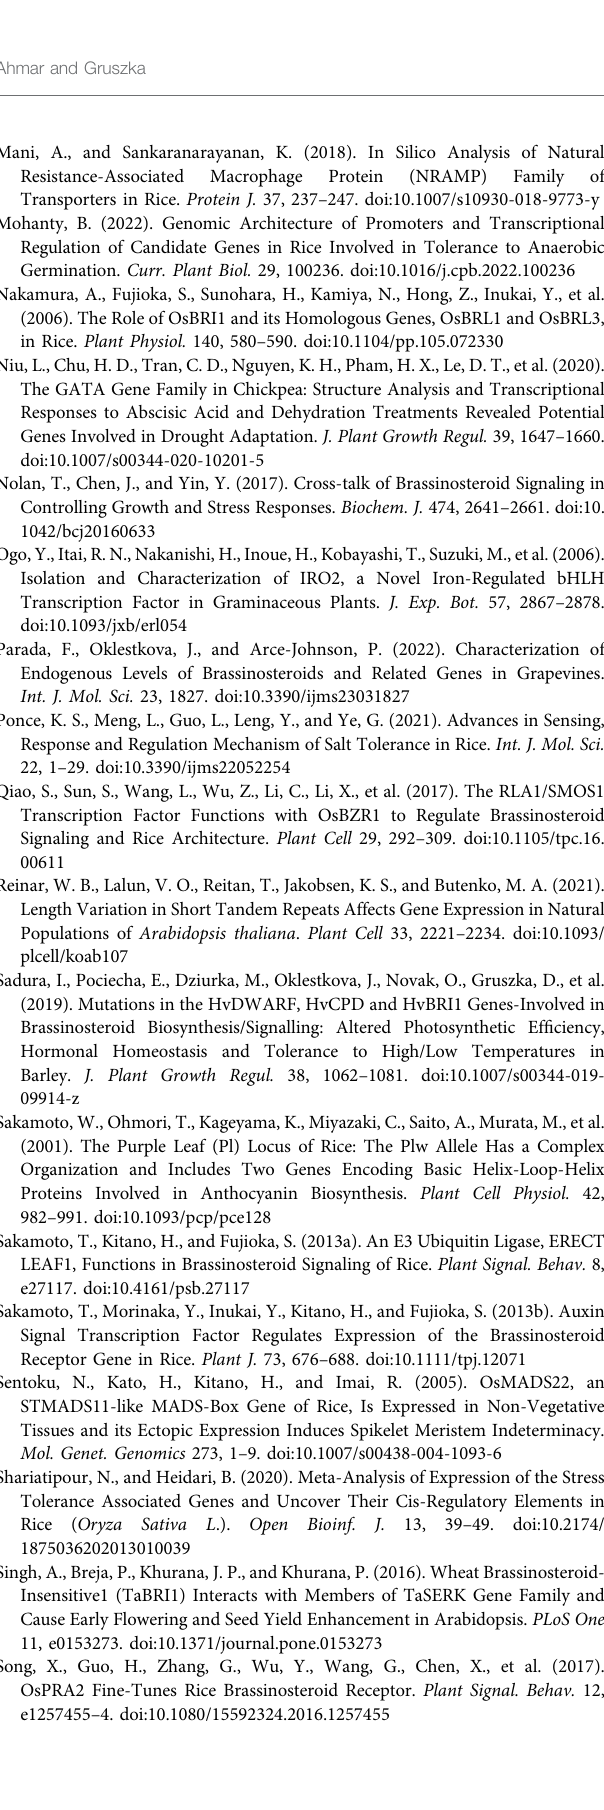
Frontiers in Genetics |